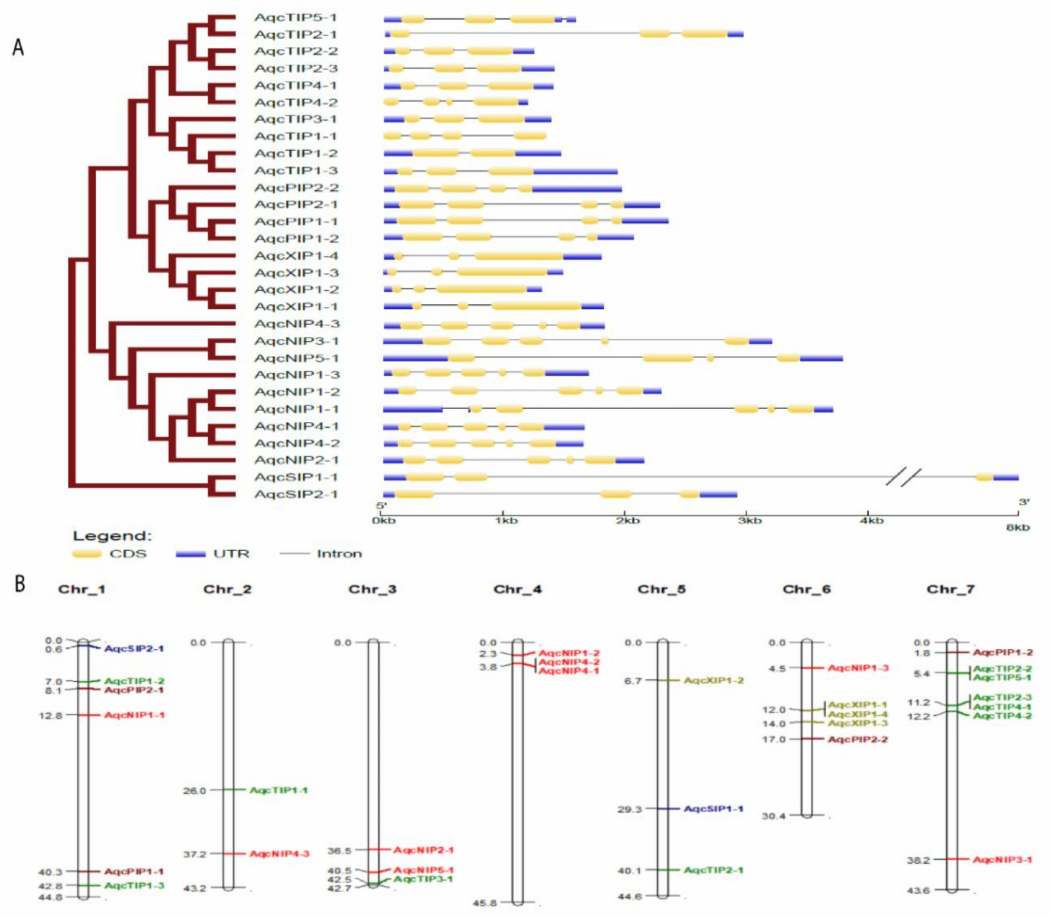
Figure 3. Intron–exon organization and chromosomal location of Aquilegia aquaporins (AQPs) ( A ). Graphic representation of the gene models of 29 AQPs identified from the Aquilegia genome shows the presence of a varied number of introns (2–5). Exons are shown as yellow boxes, untranslated regions (UTRs) in blue and introns are shown as black lines. The length of the exon and intron (bp) is indicated in kb in the x -axis. ( B ) The chromosomal location of all 29 Aquilegia AQPs is shown in the map. Di ff erent color codes were assigned to di ff erent classes of AQPs plasma membrane intrinsic proteins (PIP), nodulin 26-like intrinsic proteins (NIPs), tonoplast intrinsic proteins (TIPs), small intrinsic proteins (SIPs) and uncharacterized intrinsic proteins (XIPs). The AQPs from di ff erent subfamilies are denoted with di ff erent colors as PIP—purple; NIPs—red; TIPs—green; SIPs—blue;